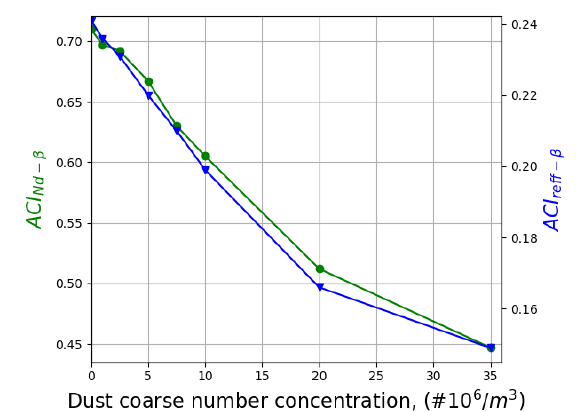
Figure A2. Accumulation mode dust ACI indexes variations due to the presence of a coarse mode.